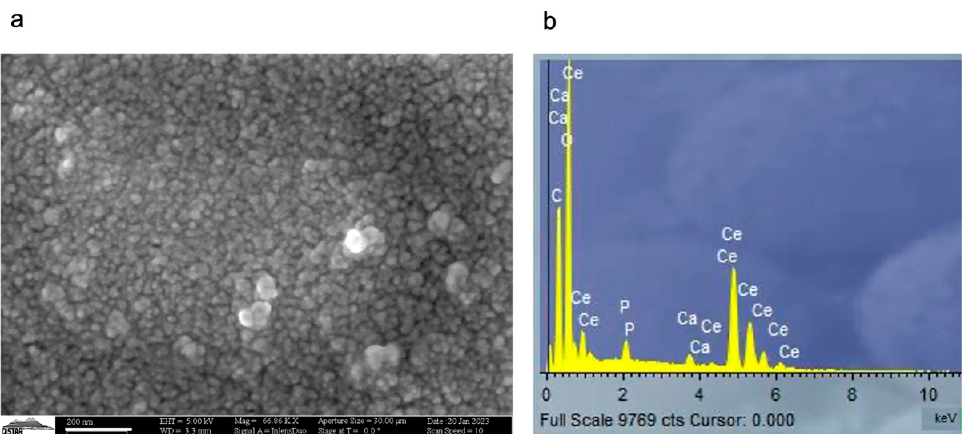
Figure 2. Structural and compositional characterization of Ce-CaP NPs . Representative SEM micro- graph ( a ) and EDS spectrum ( b ) of Ce-CaP NPs; scale bar: 200 nm. graph ( a ) and EDS spectrum ( b ) of Ce-CaP NPs; scale bar: 200